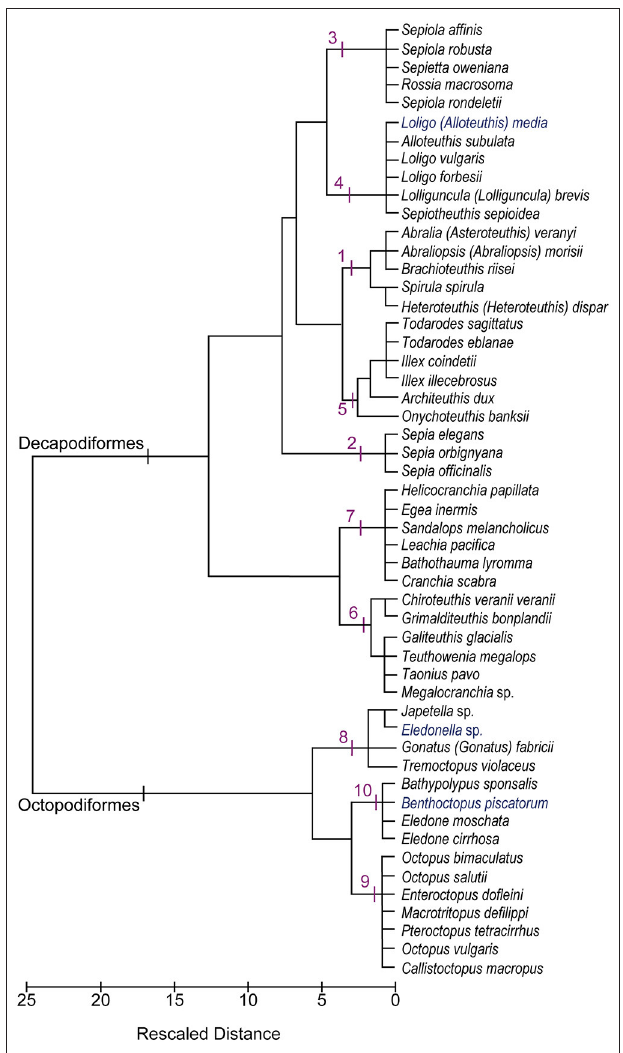
FIGURE 3 | Dendrogram after Ward’s hierarchical clustering showing the relationships among cephalopod species ( N 78). The clusters recognized are numbered from 1 to 10 and described in = the text. See also Table 3 and Supplementary Table 5 .